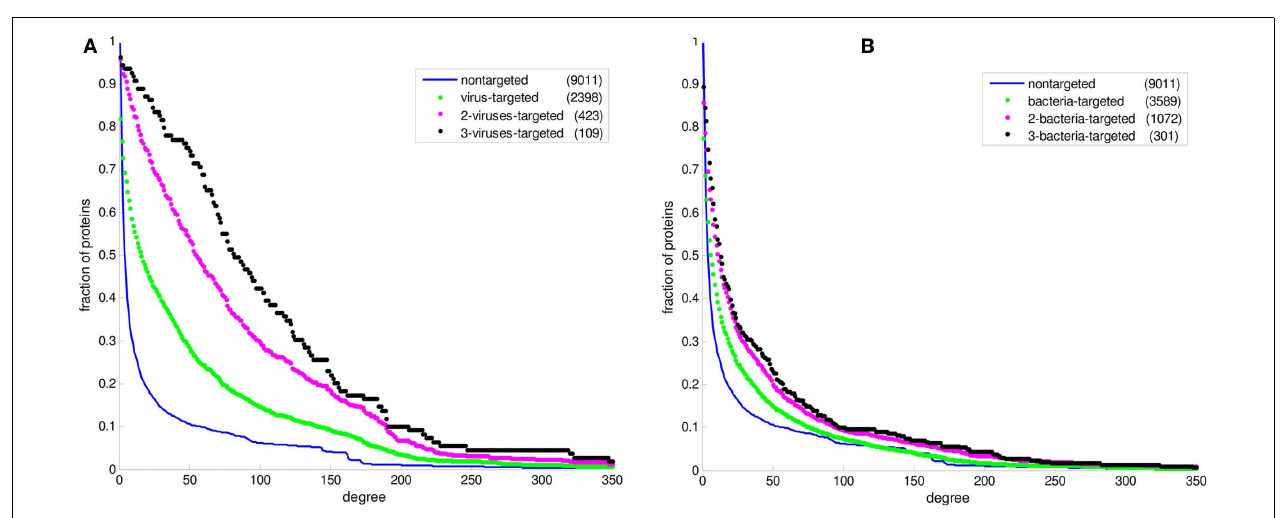
FIGURE 2 |The cumulative degree distributions of human protein sets. The distribution of all proteins in the PPI network is given in comparison with (A) the bacteria-targeted sets, and (B) the virus-targeted sets.The number of